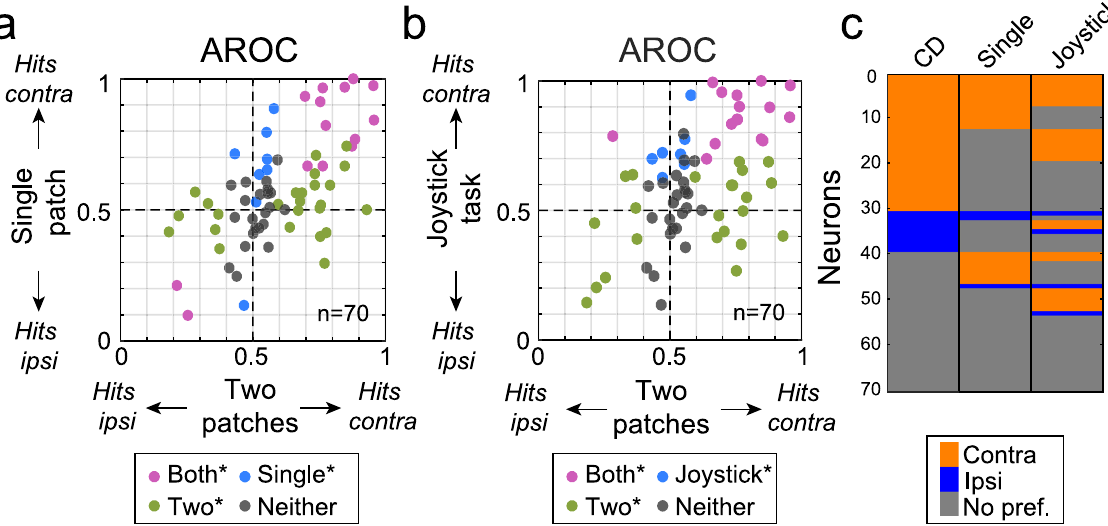
Fig 6. Influence of task context on response-choice activity. (A) Scatter plot for each caudate neuron ( n = 70) with response-choice activity comparing AROC values computed for single-patch and two-patch conditions. AROC values on the x-axis greater (less) than 0.5 indicate preference for contralateral (“contra”) (ipsilateral [“ipsi”]) hits for two-patch condition; AROC values on the y-axis greater (less) than 0.5 indicate preference for contralateral (ipsilateral) hits for single-patch condition. Color indicates the neuron’s group assignment based on the AROC values: contralateral hits versus ipsilateral hits different from chance for two patches only (Two � ; green), contralateral hits versus ipsilateral hits different from chance for single patch only (Single � ; blue), contralateral hits versus ipsilateral hits different from chance for both conditions (Both � ; purple), and neither different from chance (Neither; gray). (B) Scatter plot of AROC values computed for each caudate neuron tested with the dimming joystick task ( n = 70) with response-choice activity for two-patch and dimming joystick conditions. AROC values on the y-axis greater (less) than 0.5 indicate preference for contralateral (ipsilateral) hits for dimming joystick condition. Same conventions as A except that blue color indicates when responses to contralateral hits versus ipsilateral hits are different from chance for joystick task only (Joystick � ; blue). (C) Side preference for the motion CD task for CD with two patches (CD), single patch, and joystick task in the population of 70 caudate neurons tested with these three conditions. Each row represents a single neuron across different task conditions during the response choice period (0.3 s): two patches (CD), single patch, and joystick mapping task. Neurons were sorted according their side preference for CD task. Colors indicate side preference (orange for contralateral, blue for ipsilateral, gray for neither [“No pref.”]). Underlying data available in S1 Data. AROC, area under the receiver operating characteristic curve; CD, change detection.